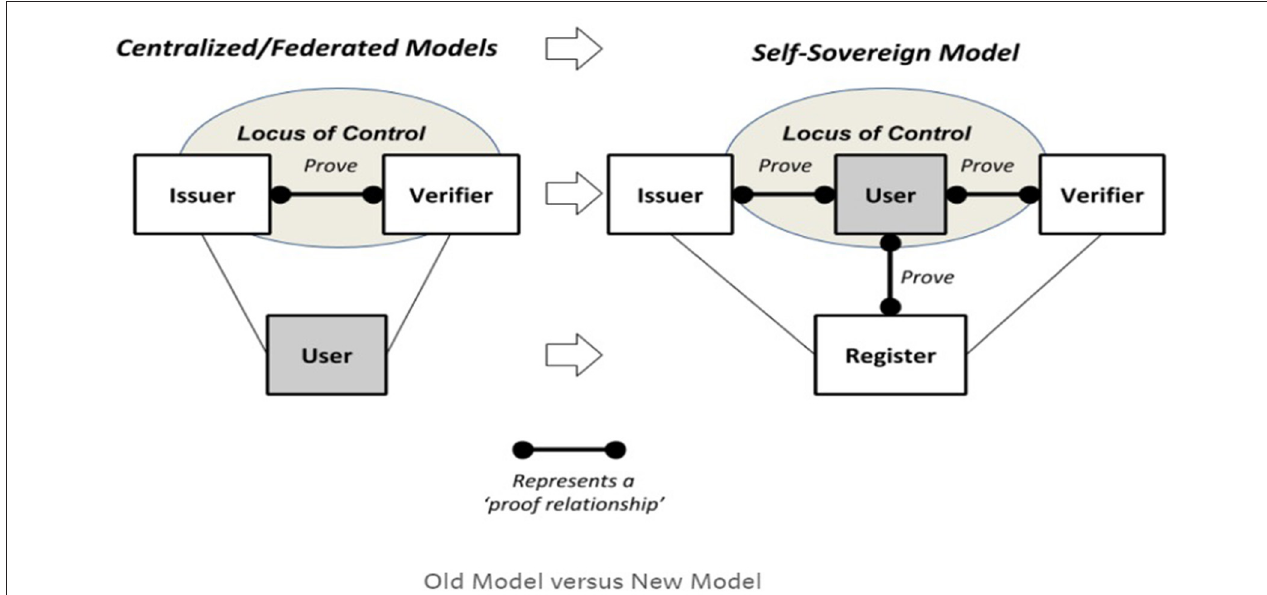
FIGURE 1 | Self-sovereign identity locus of control (Bouma,